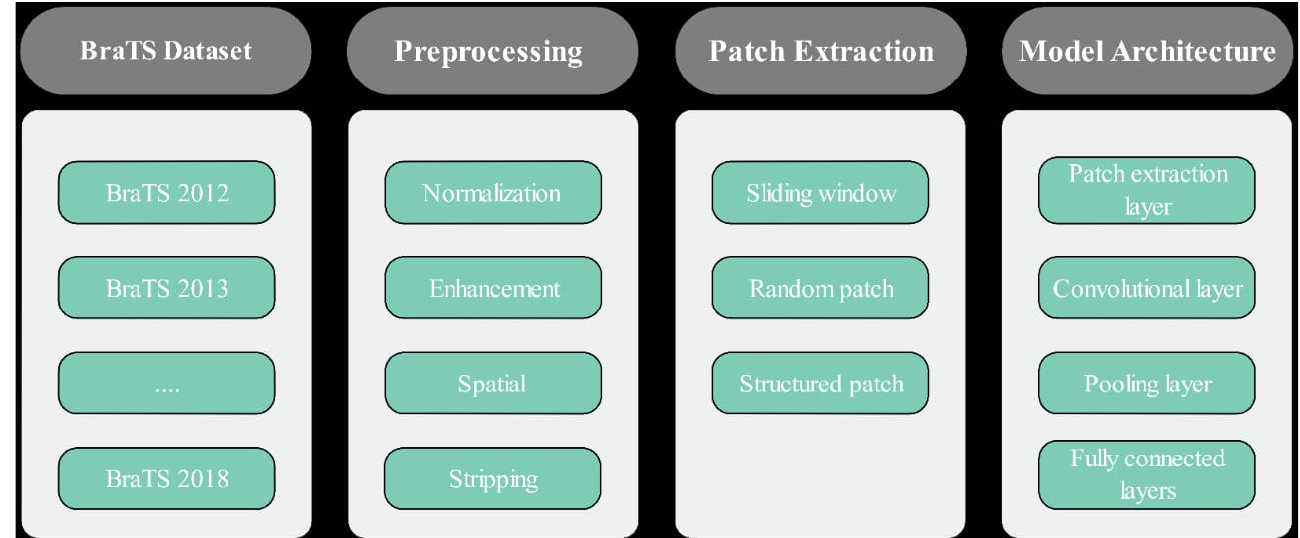
Figure 1. Proposed Brain Tumor Segmentation using Patch-based CNN.